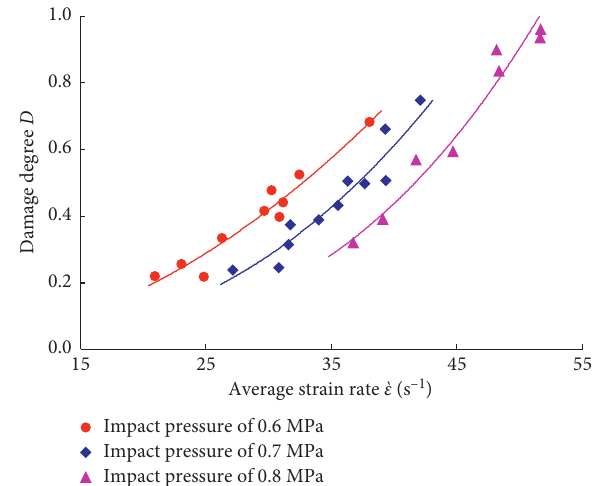
Figure 7: Relationship between the degree of damage and the average strain rate under different pressures of equal